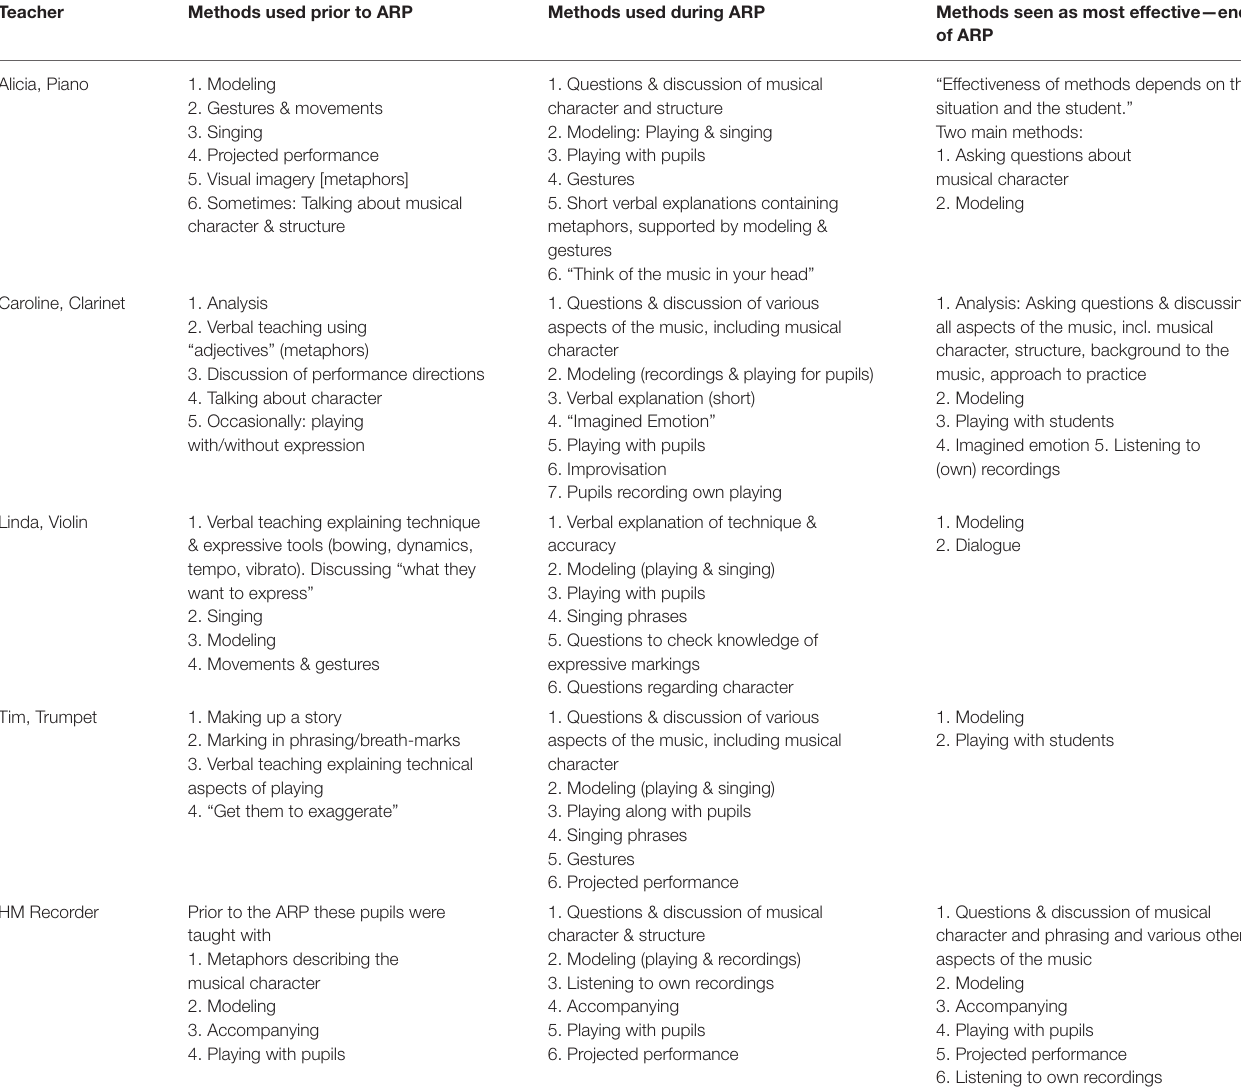
TABLE 2 | Overview of methods used by teachers prior and during the action research project, and methods described as effective afterwards.